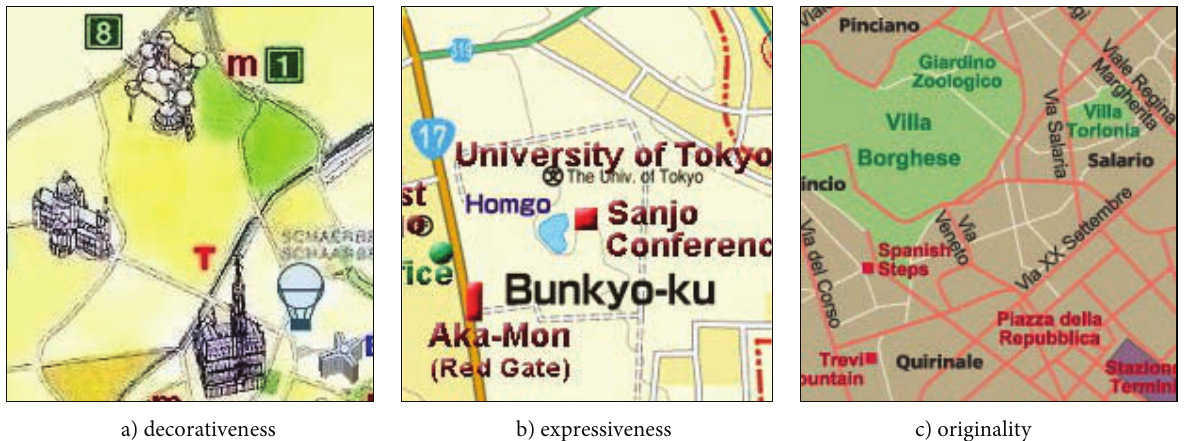
Fig. 4. Samples of street maps with one prevalent stylistic